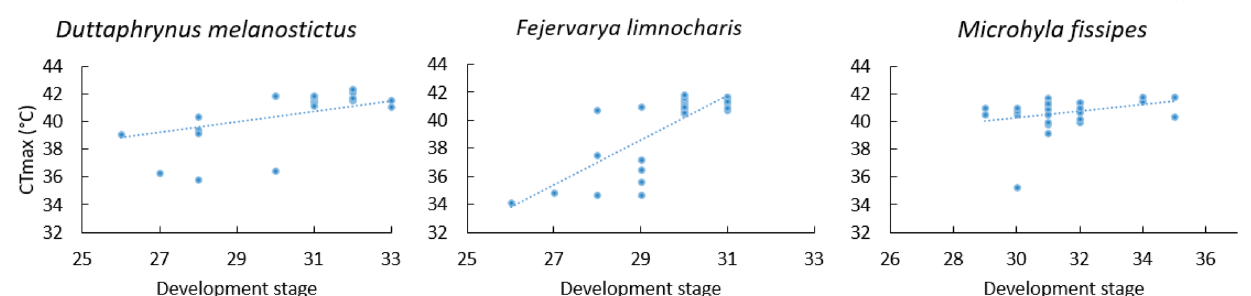
Figure 3. The critical thermal maximum (CTmax) of tadpoles under salty water. The CTmax of tadpoles of Duttaphrynus melanostictus (left), Fejervarya limnocharis (middle), and Microhyla fissipes (right) in freshwater, low and high salinity. The numbers below boxplot are sample sizes of each treatment. Data are presented as box and whisker plots. The horizontal line indicates the median value. Boxes indicate 25th and 75th percentiles; whiskers indicate minimum and maximum values. Values with different letters represent a statistical difference (Kruskal–Wallis tests with Dunn posterior tests, p < 0.05) among treatments.